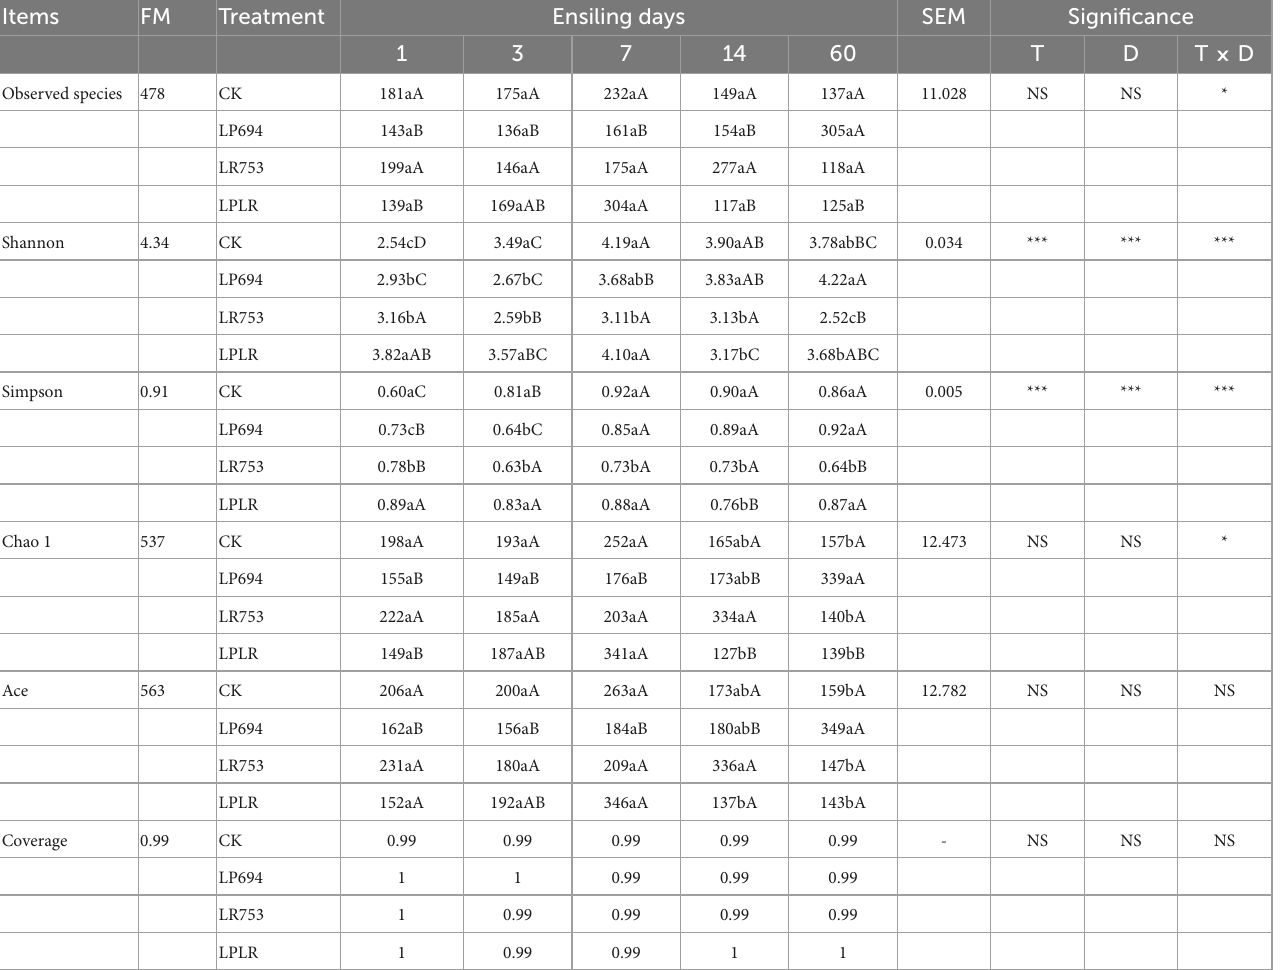
TABLE 4 Influence of lactic acid bacteria inoculation on bacterial alpha diversity of oat silages. Items FM Treatment Ensiling days SEM